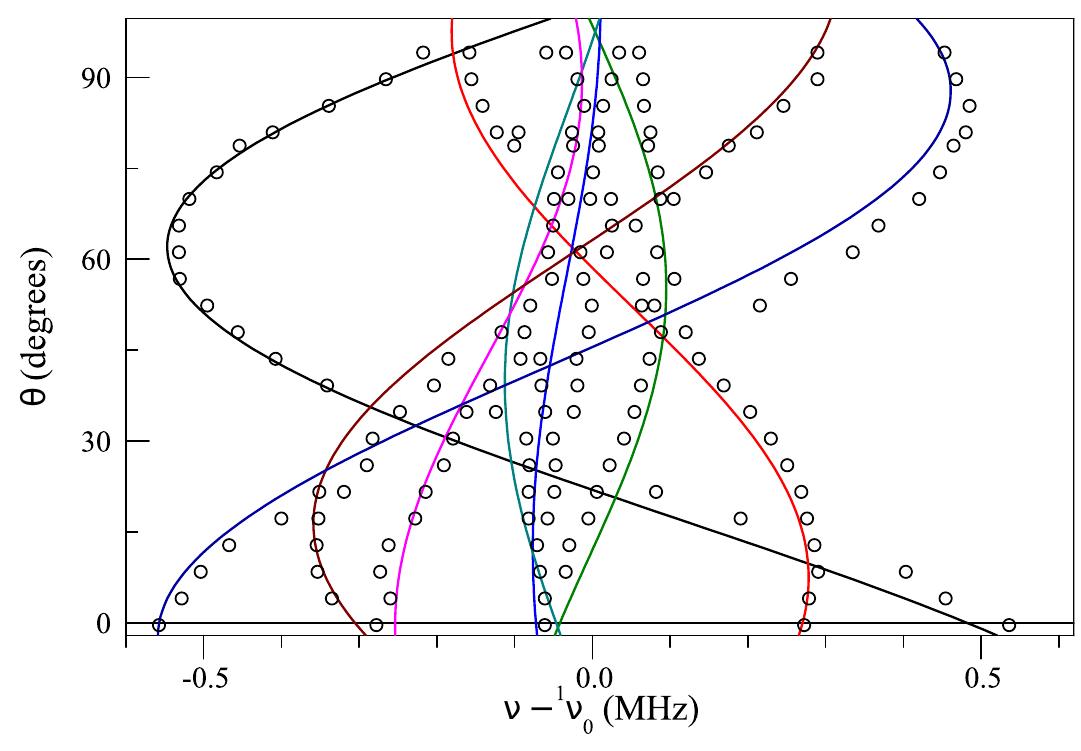
Figure 3. Angular evolution of 1 H NMR spectrum in the ( a ∗ c ) plane measured at 74 K in field H =7 T. Circles are the measured peak positions. Lines are model calculations using 0 Equation